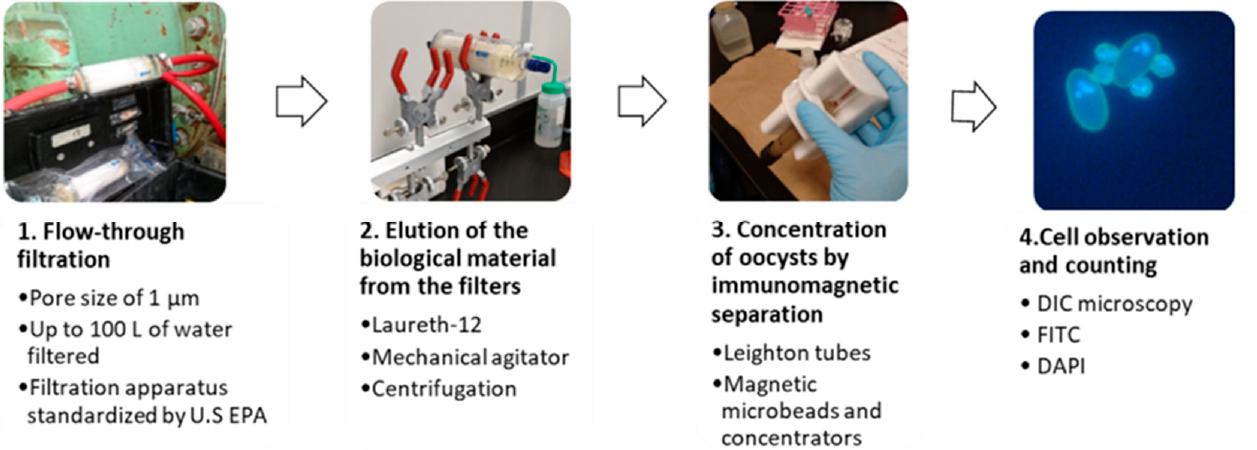
Figure 1. Key steps of the U.S. EPA Method 1623.1. The main steps of the U.S. EPA Method 1623.1 are: (1) the filtration of up to 100 L of the sample with an approved apparatus by the U.S. EPA with a pore size of 1 µ m, (2) the elution of the biological material from the filters with mechanical agitation and centrifugation, (3) the concentration of the (oo)cysts by immunomagnetic separation and (4) the observation of the samples by microscopy (DIC followed by fluorescence microscopy with fluorescent molecules DAPI and FITC).